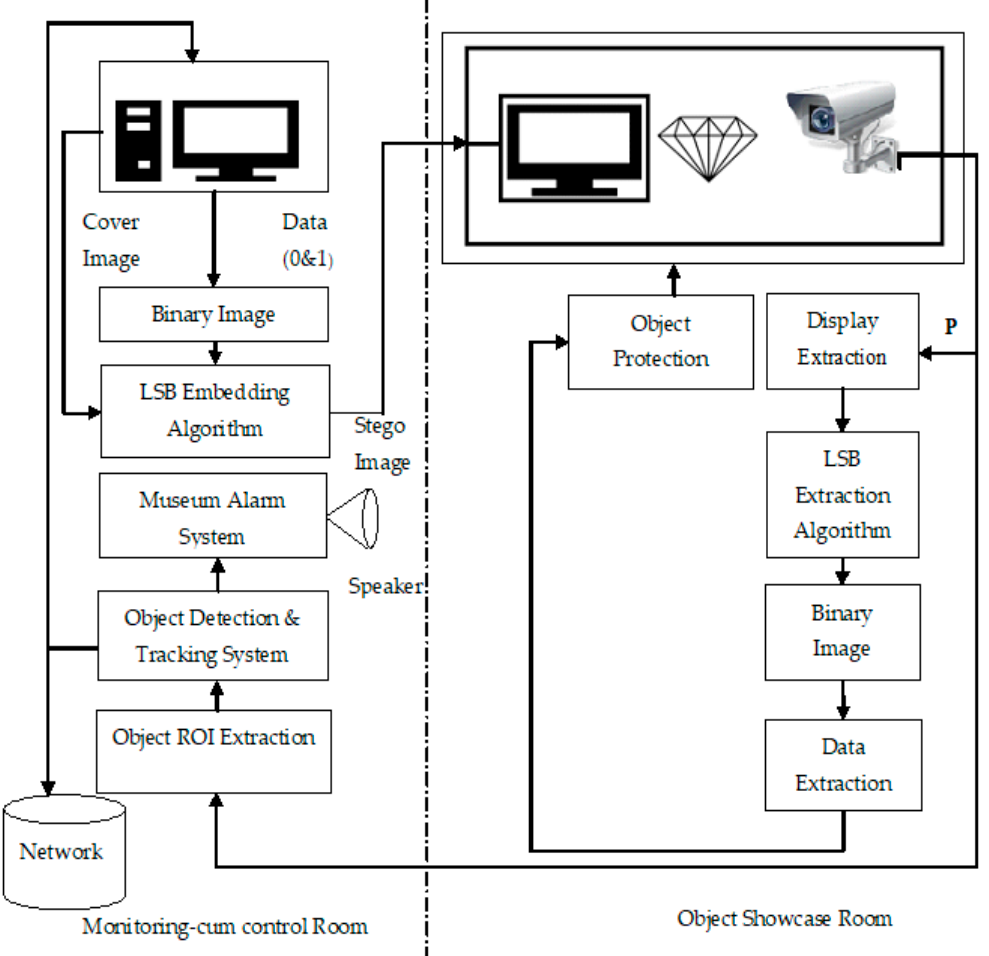
Figure 1. Block diagram representation of a proposed system.